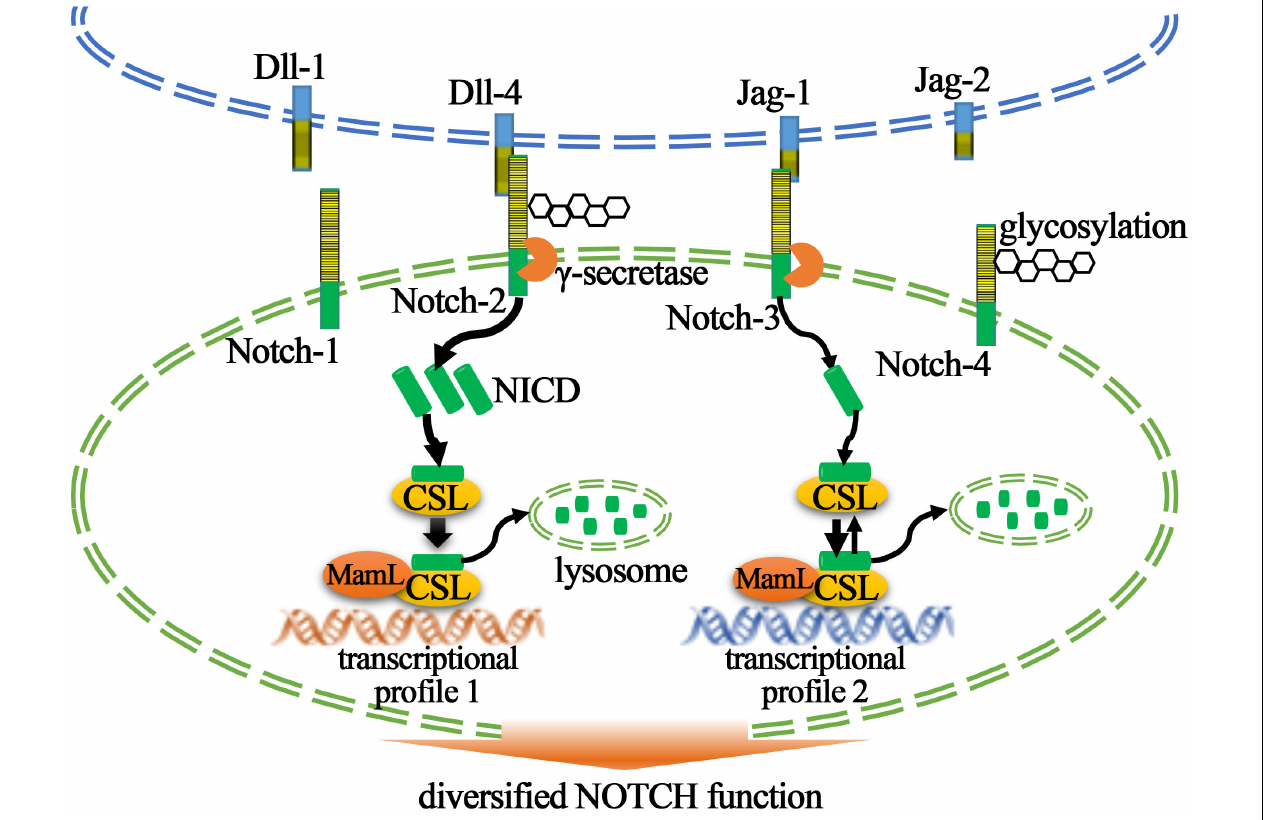
FIGURE 1 | Cartoon illustrating NOTCH signaling and its strength regulations. Binding of NOTCH ligand (Jag-1, Jag-2, Dll-1, and Dll-4) to NOTCH receptor (Notch1, Notch-2, Notch-3, and Notch-4), a process that can be influenced by glycosylation of epidermal growth factor (EGF) domain (yellow stripes), triggers γ -secretase-mediated NOTCH receptor cleavage. Notch intracellular domain (NICD) is then freed and migrates into cell nucleus where it binds with transcriptional factor CSL, increases CSL dwell time on DNA, and recruits co-factor MamL to initiate the gene transcription. The ultimate transcription profile is affected by the dosage of NICD, which is also regulated by lysosome-mediated NICD